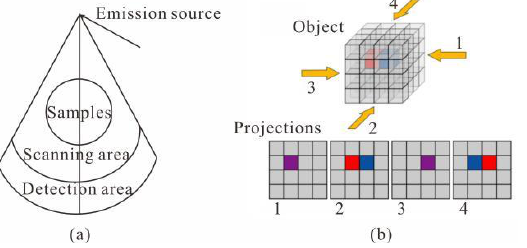
Table 1. Physical parameters of soil in cyclic freeze–thaw test.